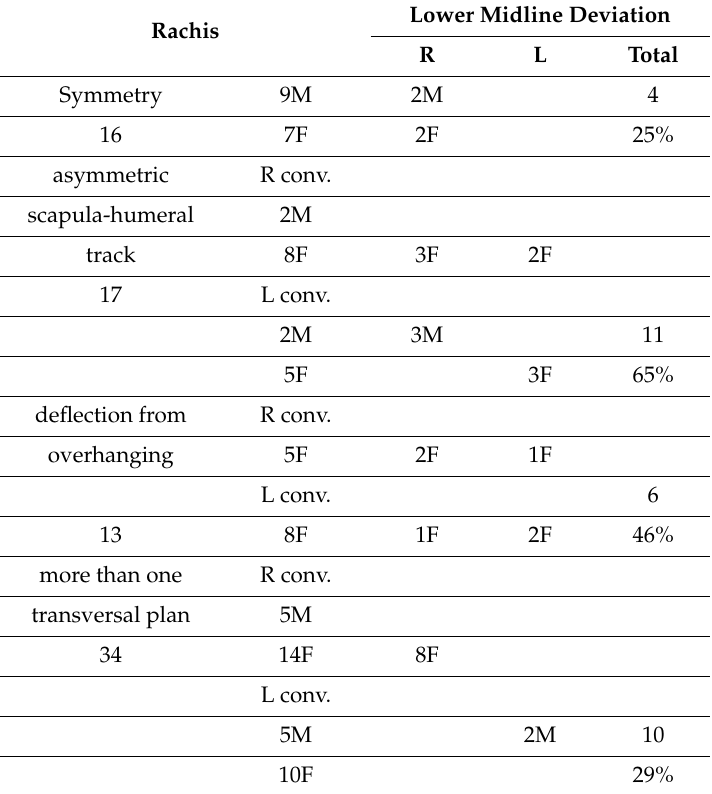
Table 8. Relations between di ff erences in transversal planes and midline deviation in our